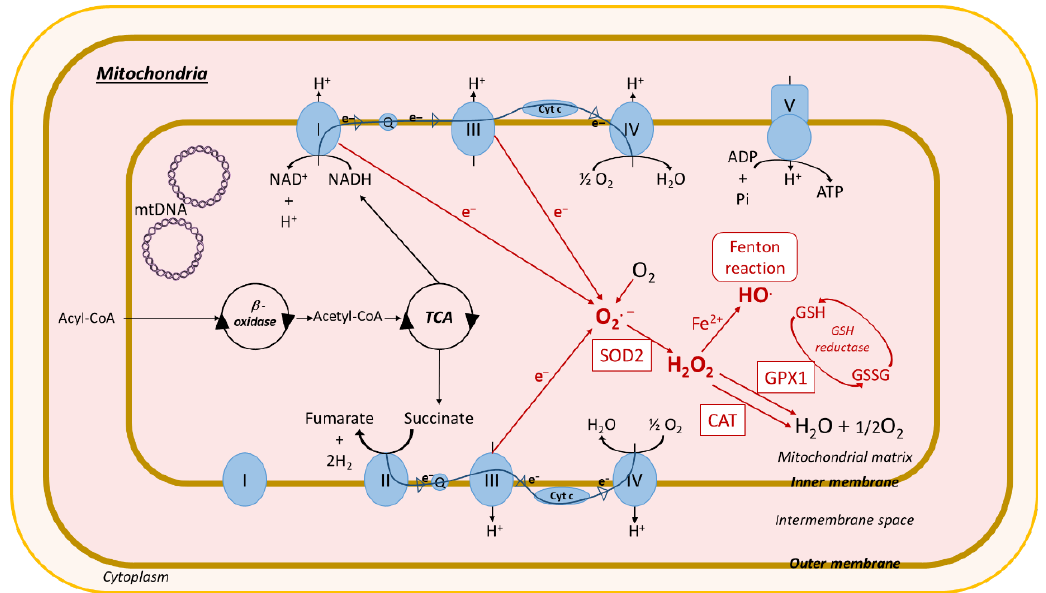
Figure 4. ROS production in mitochondria. Acyl-CoA imported into the mitochondria is converted by β -oxidation into acetyl-CoA, which enters the tricarboxylic acid cycle (TCA), resulting in the production of nicotinamide adenine dinucleotide (NADH) and succinate. Mitochondria have two respiratory chains composed of di ff erent complexes: (i) complexes I (NADH-ubiquinone oxidoreductase), III (cytochrome b-c1), and IV (cytochrome c oxidase). Complex I reduces NADH to NAD + and H + after electron (e − ) release, and (ii) complexes II (succinate-quinone oxidoreductase), III, and IV. Complex II catalyzes the dehydrogenation and oxidation of succinic acid into furamate and 2H 2 after e − release. Released electrons pass through complexes and other molecules in the mitochondria inner membrane ubiquinone (Q) and cytochrome c (cyt c). Complex V (F1F0-ATP synthase) uses the chemiosmotic proton gradient to power the synthesis of ATP from adenosine-diphosphate (APD) and Pi. In red: impairment of the electron transport chain results in the leakage of e − that react directly with oxygen to form the superoxide anion radical transformed in H 2 O 2 through SOD2 activity. H 2 O 2 can react with Fe 2 + to form OH . (Fenton reaction). H 2 O 2 is processed into H 2 O and O 2 by the antioxidant enzymes GPX1 and catalase. Mitochondrial ROS production causes oxidative mtDNA, lipid, and protein damage. Other abbreviations: CAT, catalase; GPX1, glutathione peroxidase 1; SOD2, superoxide dismutase; Fe 2 + , ferrous iron; O 2 , oxygen; H 2 O, water; HO . , hydroxyl radical; O 2. − , superoxide; H 2 O 2 , hydrogen peroxide; ATP, adenosine-triphosphate; Pi, inorganic phosphate; NAD + , nicotinamide adenine dinucleotide; H + , hydrogen; mtDNA, mitochondrial DNA; GSH, glutathione; GSSG, oxidized glutathione; ROS, reactive oxygen